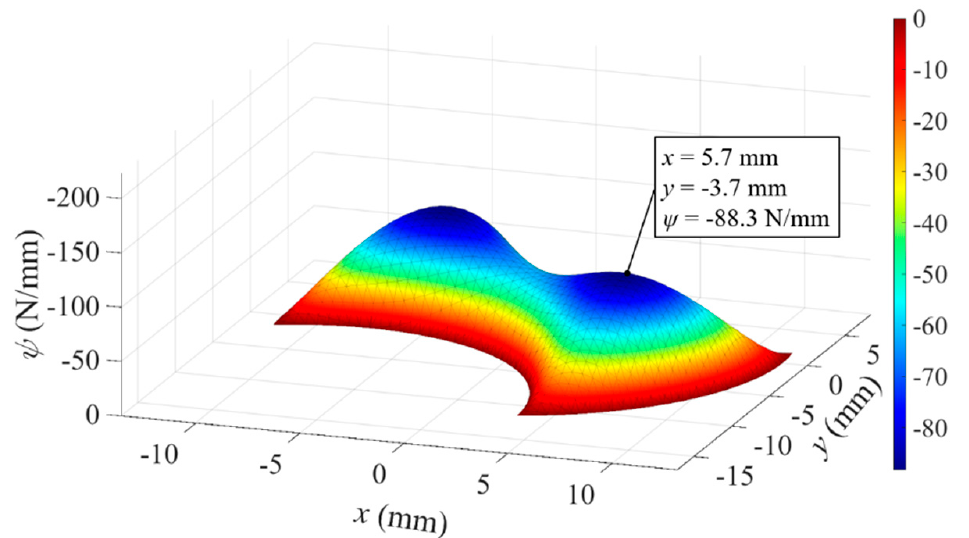
Figure 3. Prandtl’s stress function ψ for the cross-section shown in Figure 2a; in local minima points, the shear stress components (derivatives of Prandtl’s stress function) are zero.